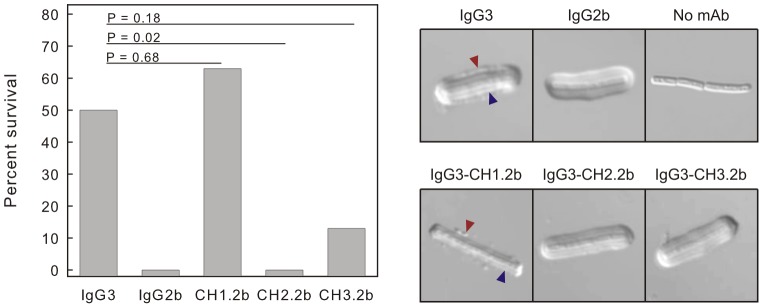
Protection and capsule reactivity of heavy-chain hybrids of IgG3/IgG2b (IgG3-CH1.2b, IgG3-CH2.2b, and IgG3-CH3.2b).See Fig. 4 for nomenclature. Left - Mice (n = 8/group) were treated with 800 µg of mAb and challenged 18 h later with 10 LD50 of B. anthracis (Ames) spores. Percent survival was evaluated using the Fisher exact test compared to the IgG3 treatment group. Right – Capsule reaction produced by incubation of B. anthracis vegetative cells with mAb F26G3 or the indicated hybrids of IgG3/IgG2b (75 µg/ml). Note reactivity of the IgG3 and IgG3-CH1.2b at both the outer edge (blue arrow) and an inner layer near the cell wall (red arrow).